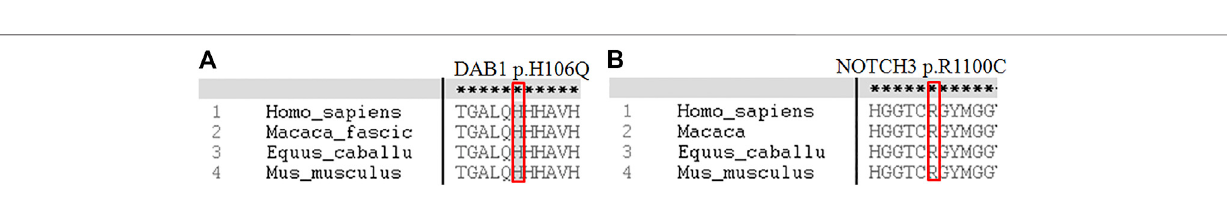
FIGURE 4 | Evolutionary conservation analysis of multiple sequence alignments of DAB1 (A) and NOTCH3 (B) protein. The comparison between different eukaryotic species, showing that the base pair involving the nucleotide at position 318 in DAB1 and 3298 in NOTCH3 are highly conserved.